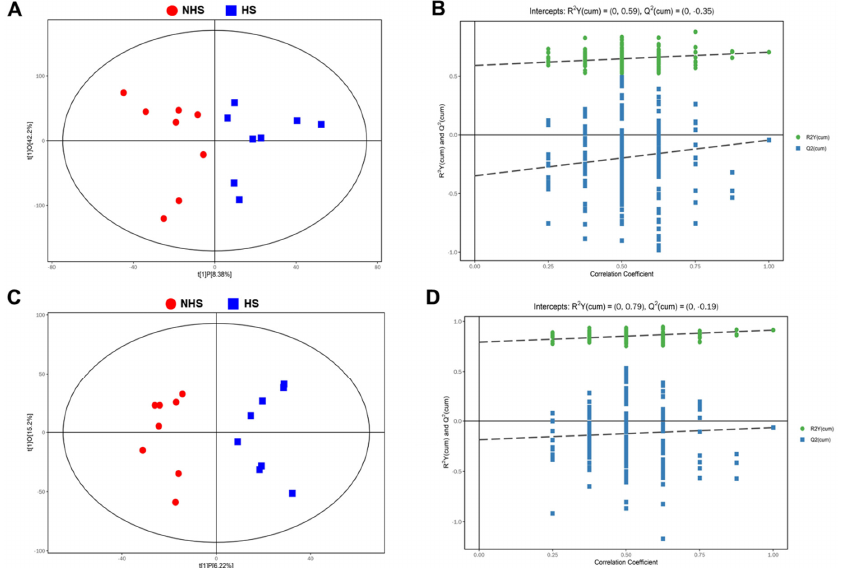
Figure 2. The scatter and permutation plot of OPLS-DA model. ( A , C ) OPLS-DA score scatter plots of sperm metabolites in the positive and negative ion modes. The plots were used to analyze the segregation of sperm samples between NHS and HS groups. Red marks NHS group, blue denotes HS group. ( B , D ) OPLS-DA permutation plots of sperm metabolites in the positive and negative ion modes. The slope of R2 is >0 and the Y-intercept of Q2 is <0.05, indicating a valid model.